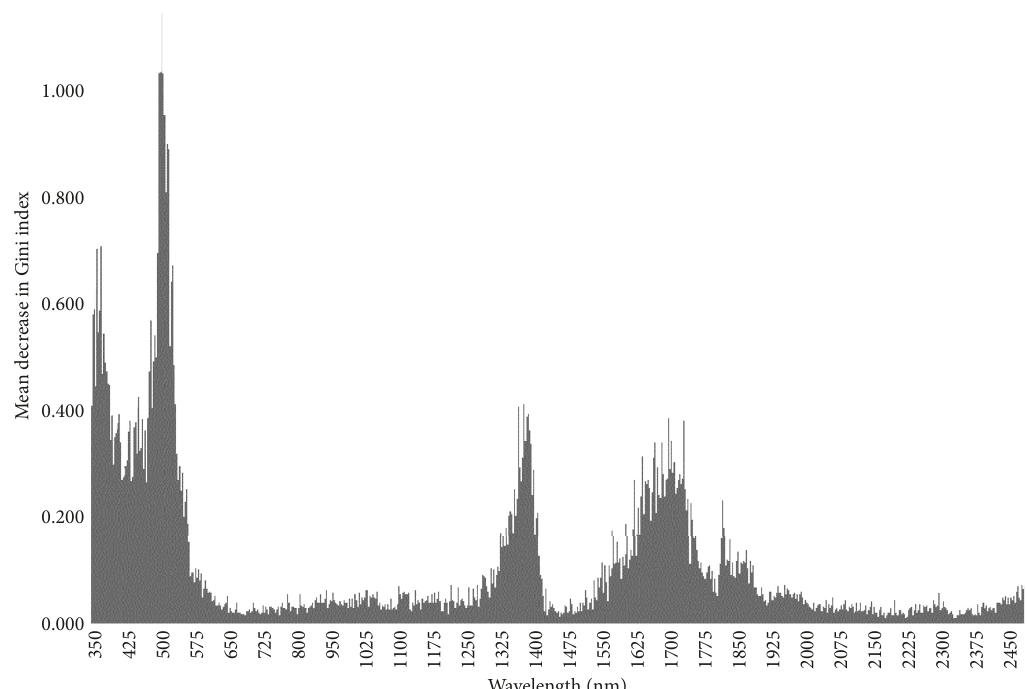
Figure 7: Variable importance measurement produced by the RF algorithm for all variables (2151 wavelengths). High mean decrease in the Gini index reflects the most important